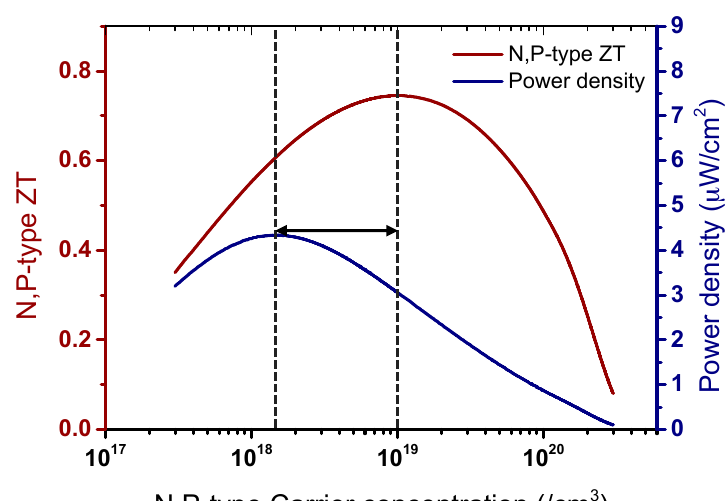
Figure 3. The material ZT and the power density of P-type BiSbTe 3 according to carrier concentration. The carrier concentration of the maximum power density shifted to the left side from the ZT maximum point.